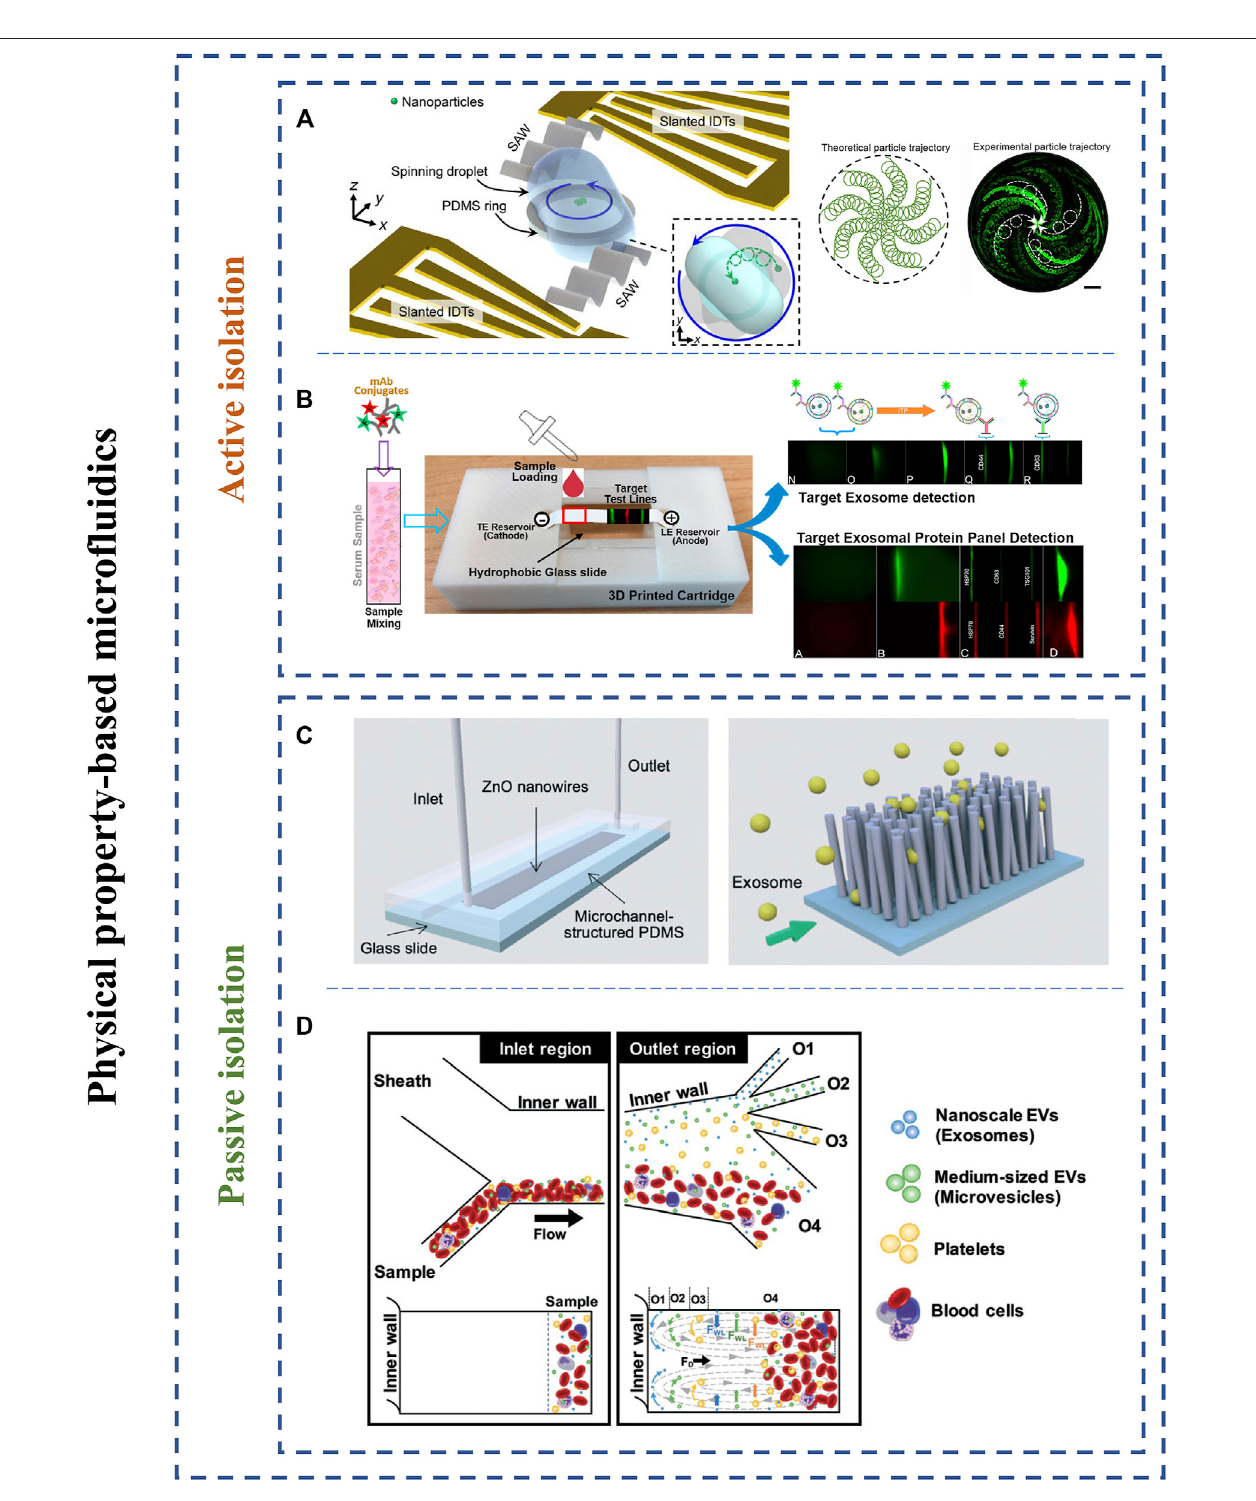
FIGURE 6 | Schematic representation of physical property-based micro fl uidic isolation techniques. (A) An acoustic-based separation micro fl uidic chip employing acousticforcesanddropletspinningforisolationofexosomesfrombio fl uids.Adaptedfrom(Guetal.,2021),copyright2021AmericanAssociationfortheAdvancement of Science. (B) An electrical-based separation device integrated the focusing power of isotachophoresis and paper-based fi ltering ability. Adapted from (Guo et al., 2020), copyright 2020 Elsevier Ltd. (C) A ZnO nanowires array for exosome capture. Adapted from (Suwatthanarak et al., 2021), copyright 2021 Royal Society of Chemistry. (D) Hydrodynamic-based micro fl uidic strategy for isolating exosomes from whole blood. Adapted from (Tay et al., 2021), copyright 2021 Royal Society of Chemistry.